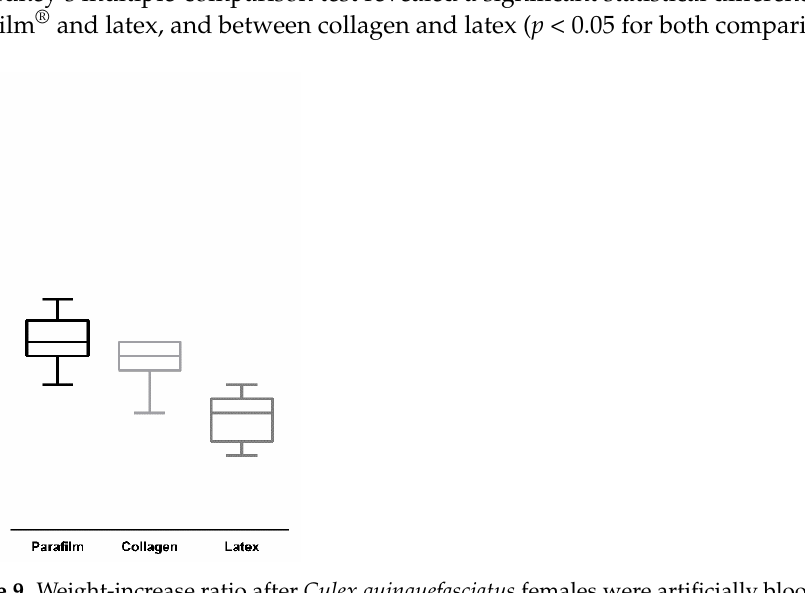
Figure 8. Egg hatchability after Culex quinquefasciatus females were artificially blood-fed through different membranes (bars = ± SEM).